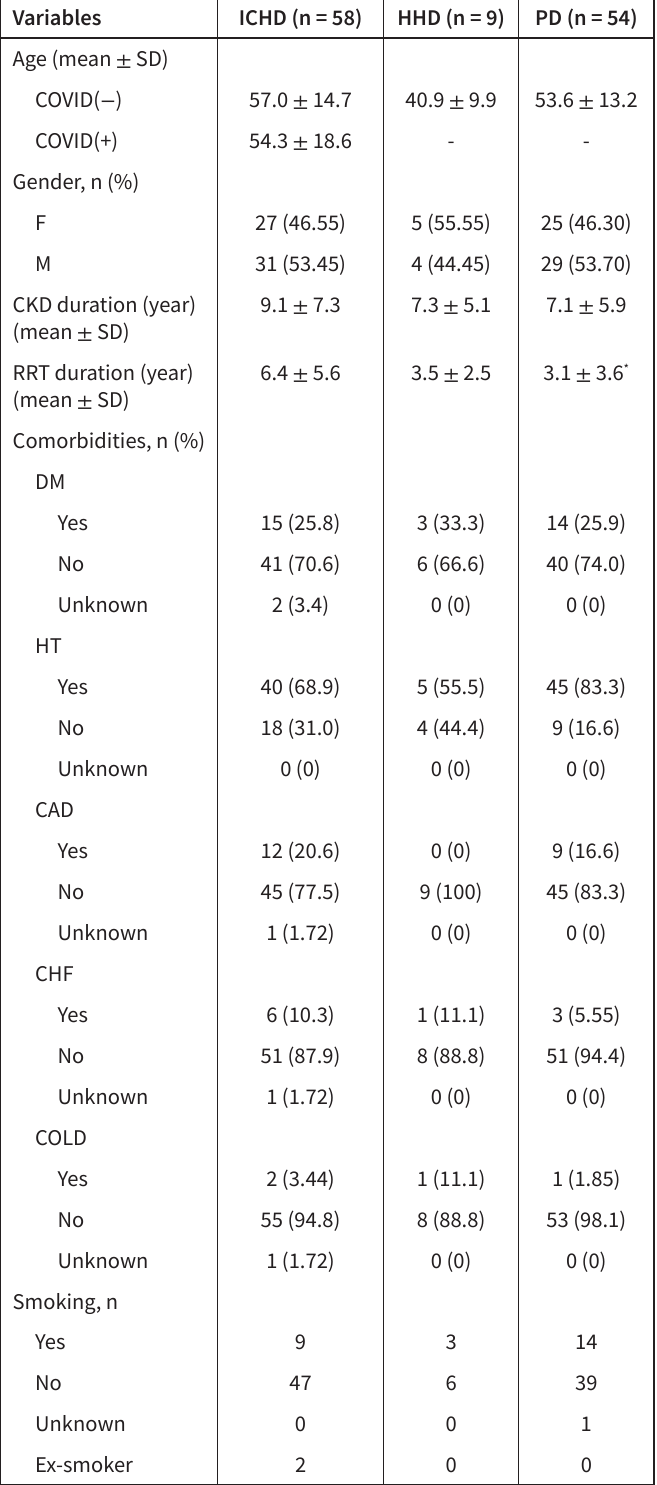
Table 1. The Granular Descriptive Statistics of the Analyzed